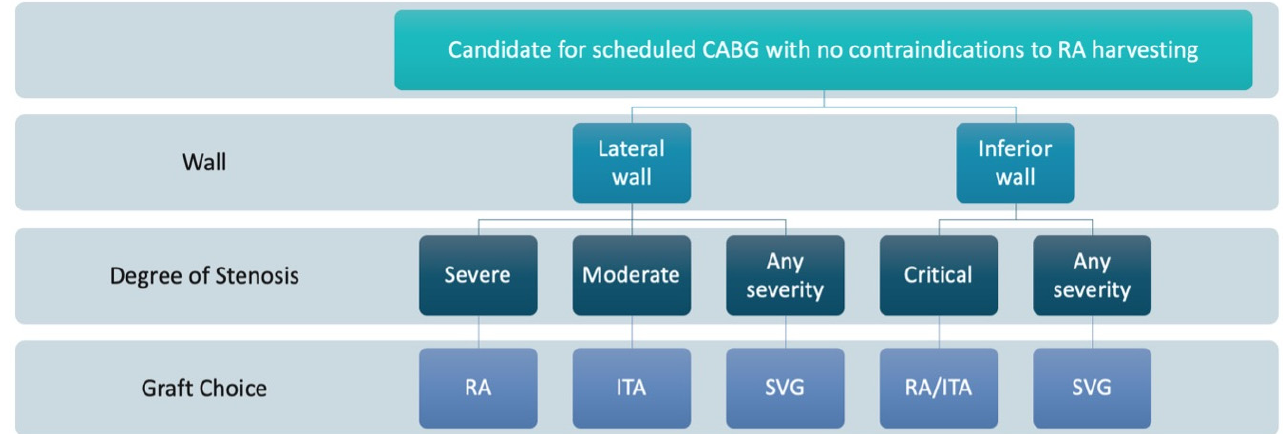
Figure 1. Flowchart for patient selection for single versus multiple arterial grafting in coronary artery bypass grafting (CABG). Adapted from Gaudino et al. [29]. ITA—internal thoracic artery; RA—radial artery; SVG—saphenous vein graft.